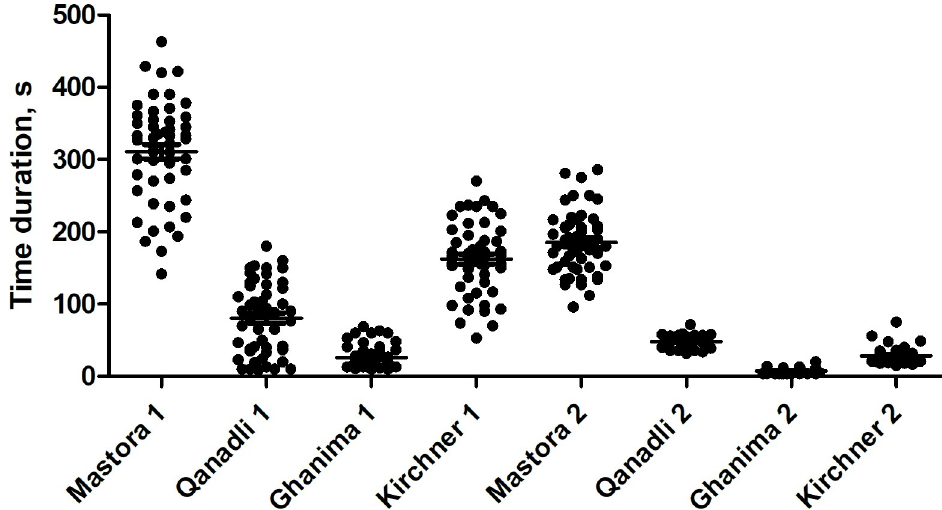
Fig 2. Scatter plot displaying the time duration for scoring in seconds (s). For reader 1, Mastora took the longest time duration, followed by Kirchner et al., Qanadli and finally Ghanima (every test p < 0.0001). For reader 2, Mastora also took the longest time duration, followed by Qanadli, Kirchner and Ghanima (every test p < 0.0001). There were significant differences between reader 1 and 2 in regard of time duration. So, reader 2 was significantly faster for every score (p < 0.0001 for every score).